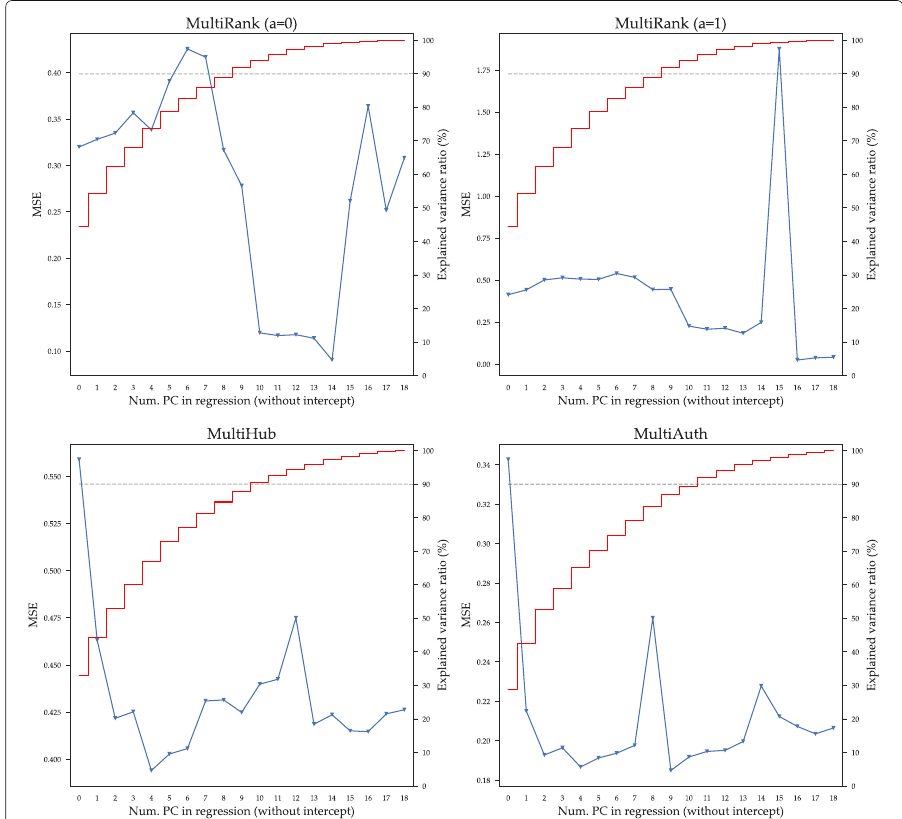
Fig. 23 In red: number of principal components sufficient to explain 90% of the variance of the measures of centrality calculated on the single layers (scale reported on the right y-axis). In blue: mean square error obtained by regressing the multilayer measures of centrality against the principal components of the single layer centralities, added one after one (scale reported on the left y-axis). All results refer to the cross section in